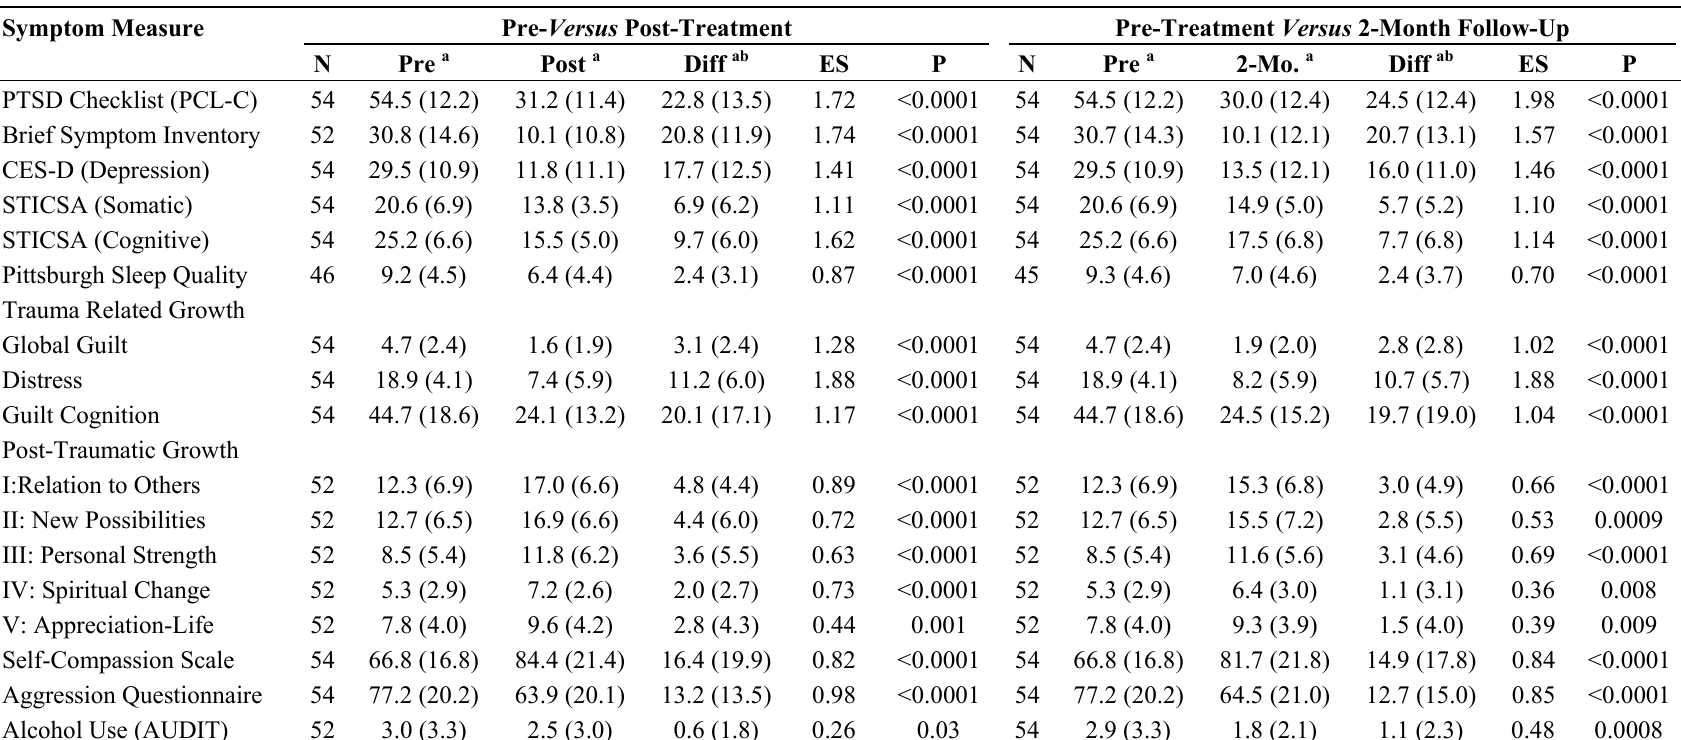
Table 2. Self-Report Changes in Symptoms Before and After Treatment with